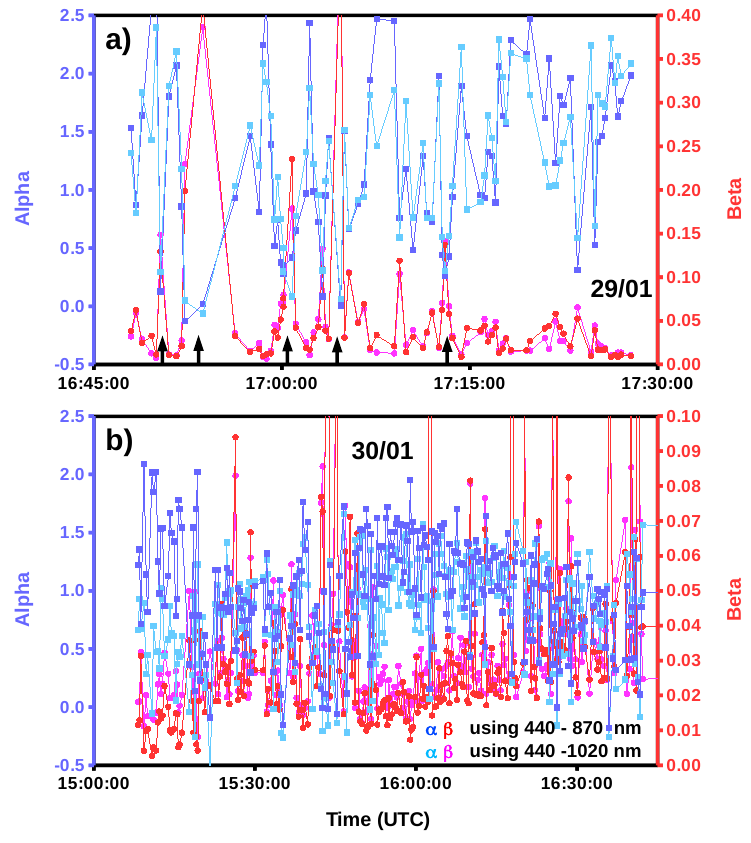
Figure 4. Volcanic plume α p and β p observations for 29 January ( a ) and 30 January 2011 ( b ). Determinations with different wavelength pairs are shown, 440/1020 nm ( α p : blue, β p : red) and 440/870 nm ( α p : sky blue, β p :